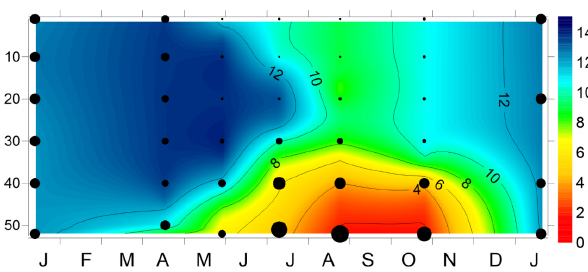
Figure 9. Time series of vertical distribution of oxygen and phos- phate concentration at station G1 in the Gulf of Riga from Jan- uary 2018 to January 2019. Phosphate concentrations are indicated as black dots. The size of the dots is proportional to the mea- sured concentrations ranging from the lower detection range of 0.06 to